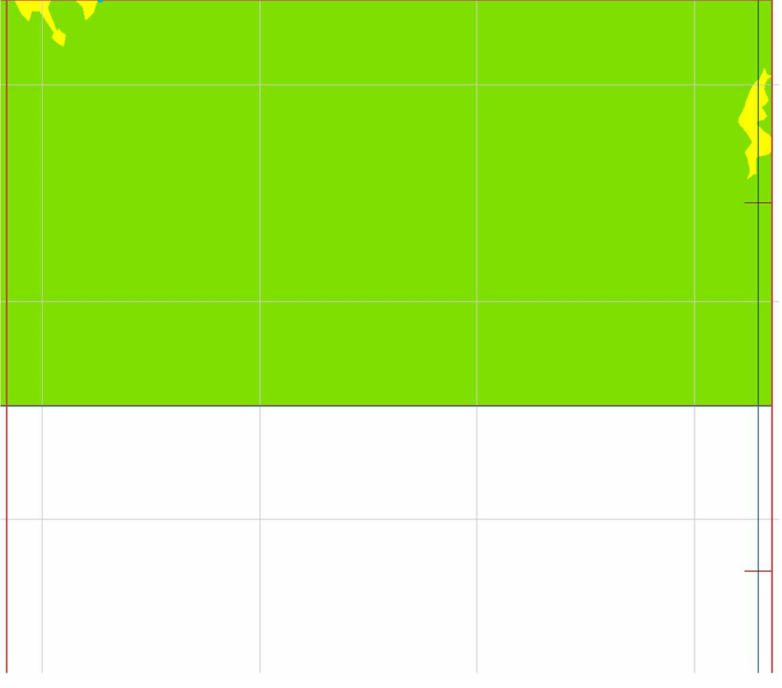
Figure 16. Utilization ratio of EW in contour before cutout